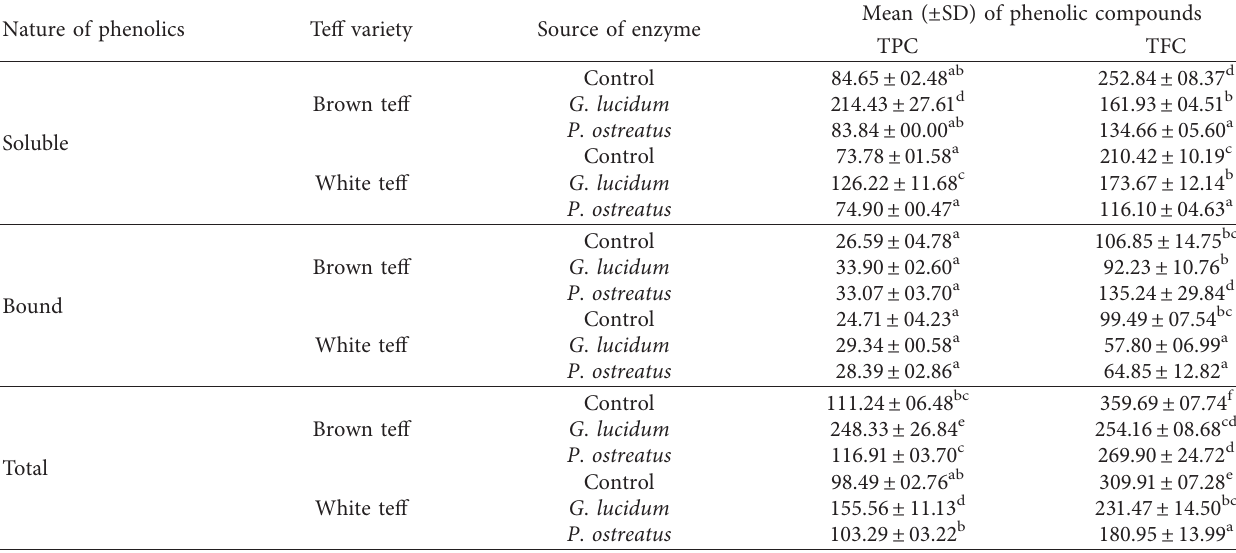
Table 1: ANOVA results of data on changes in TPC and TFC of teff due to fungal mycelia-based solid-state fermentation. Nature of phenolics Teff variety Source of enzyme